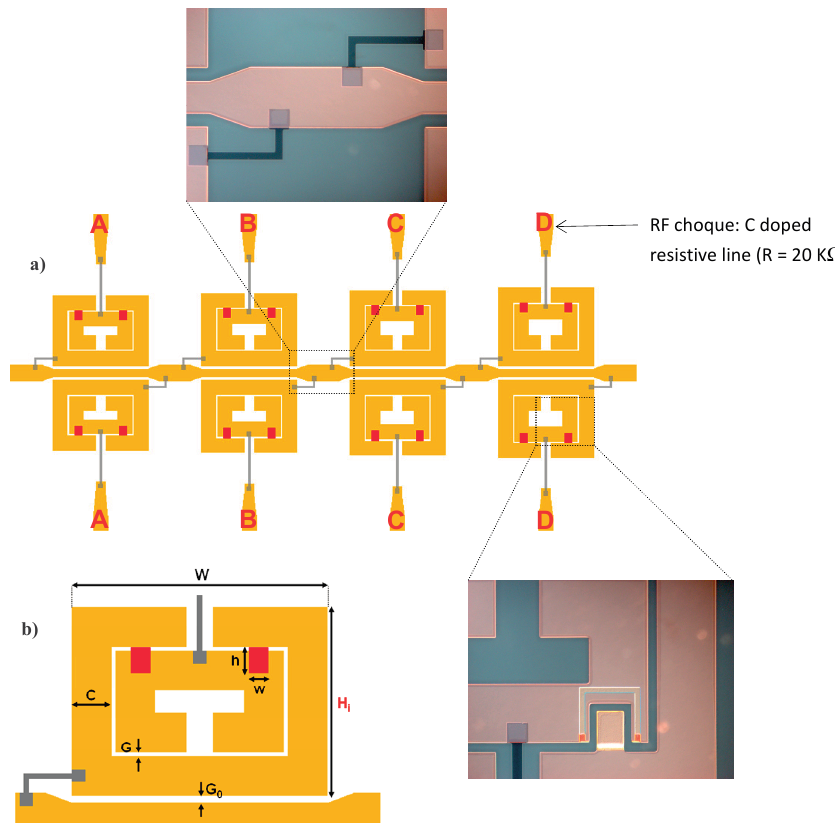
Figure 9. Layout of the four-pole reconfigurable bandstop filter ( a ) and over scale view of one RF-MEMS-loaded SRR ( b ). The total size of the device is 6.4 × 14 mm 2 . The dimensions of the cantilever-type MEMS are h × w = 200 μ m × 150 μ m. Width